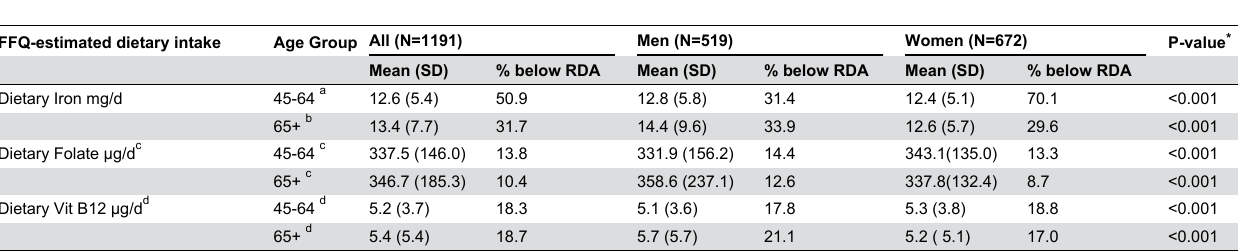
Table 2. Estimated Dietary Intakes of Iron, Folic Acid and Vitamin B12 by Gender and Age Group.